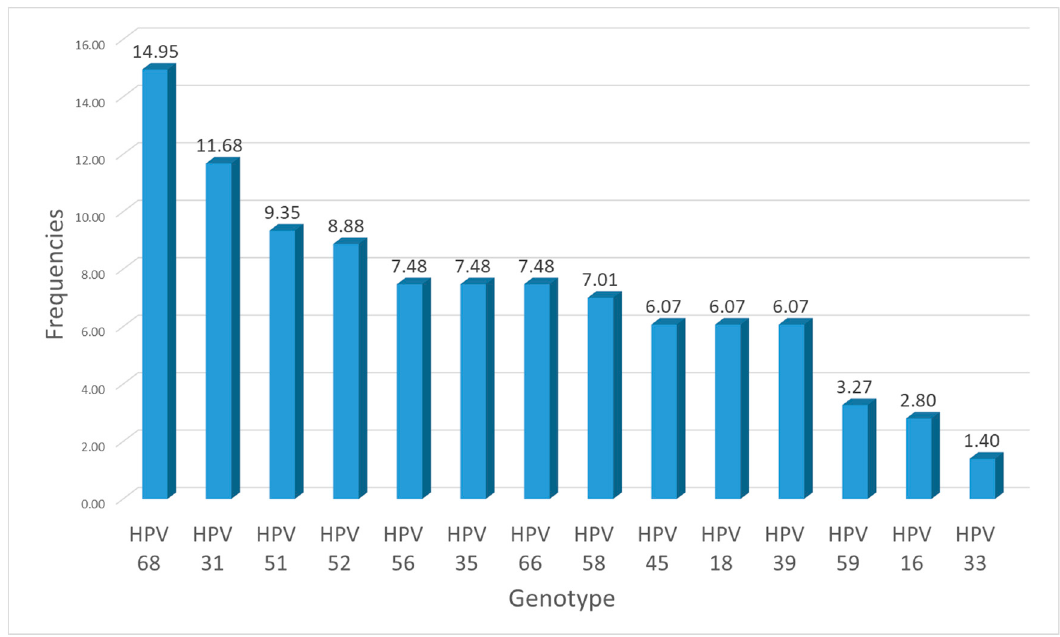
Figure 1. Histogram of the 14 HPV genotypes found in our study in relation to their total number. HIV Status of Patients